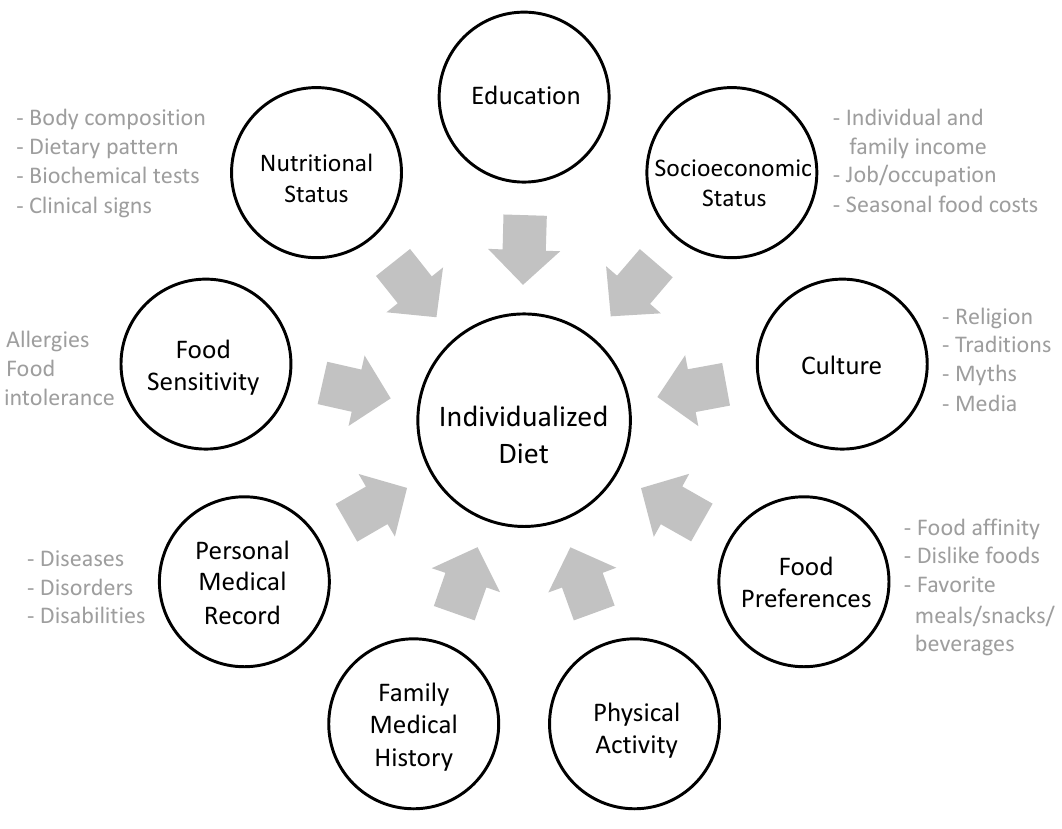
Figure 1. Interrelation of individual and environmental determinants considered to design individualized dietary interventions.